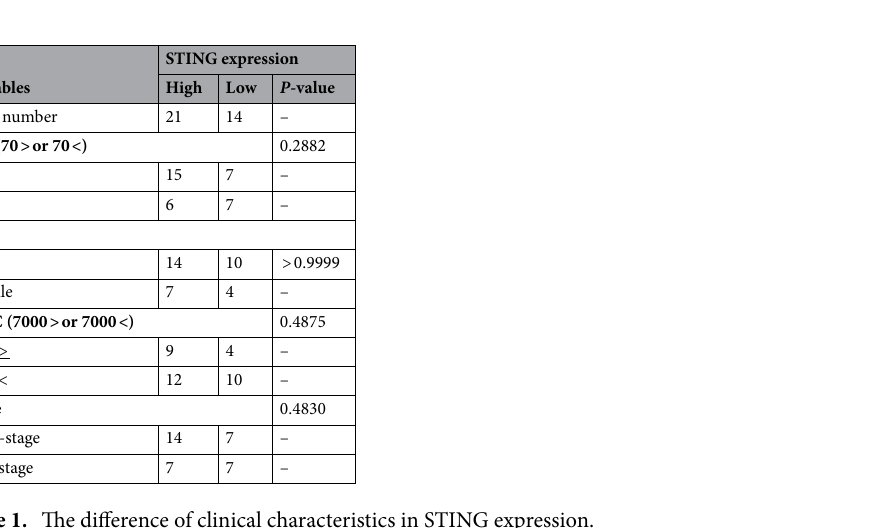
Table 1. The difference of clinical characteristics in STING